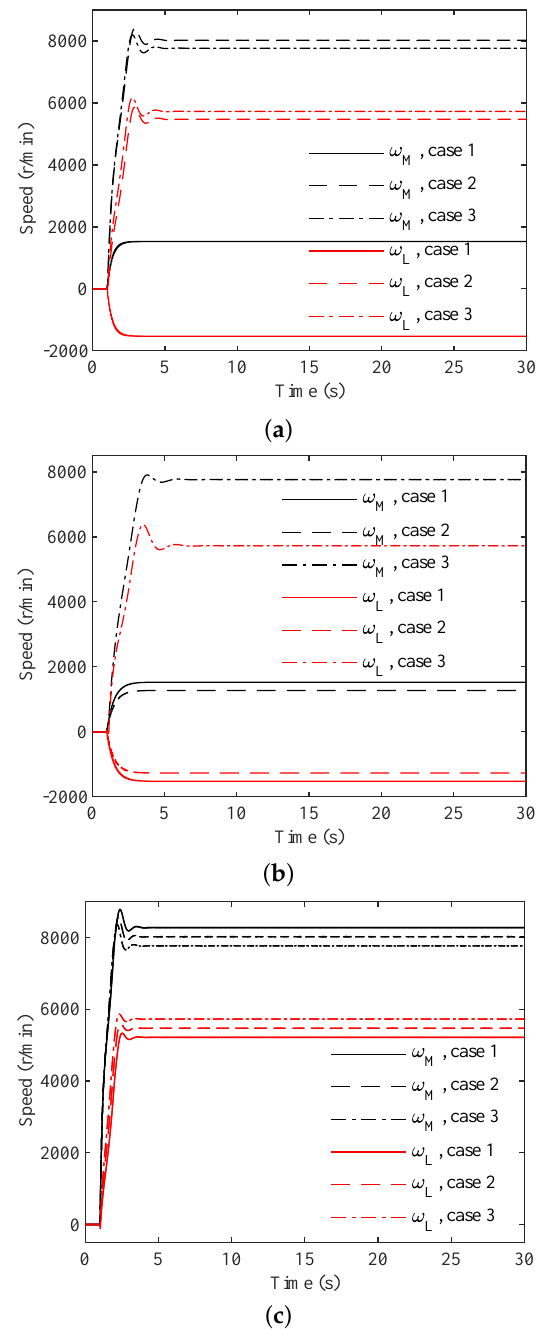
Figure 4. Simulation results of on-load startup: ( a ) R = 1 ( J M = 0.001 kg · m 2 ); ( b ) R = 0.5 ( J M = 0.002 kg · m 2 ); ( c ) R = 2 ( J M = 0.0005 kg · m 2